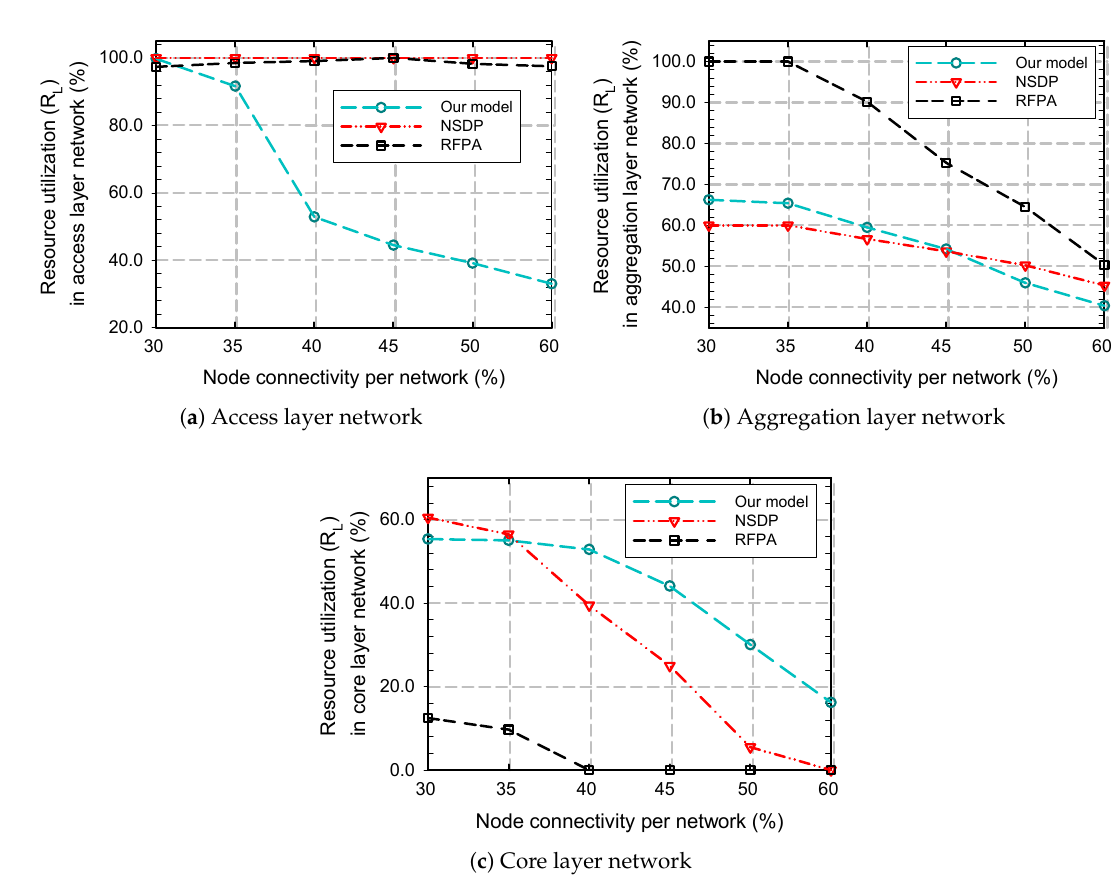
Figure 9. Average substrate link load in three-layer networks comparing among proposed model, NSDP and